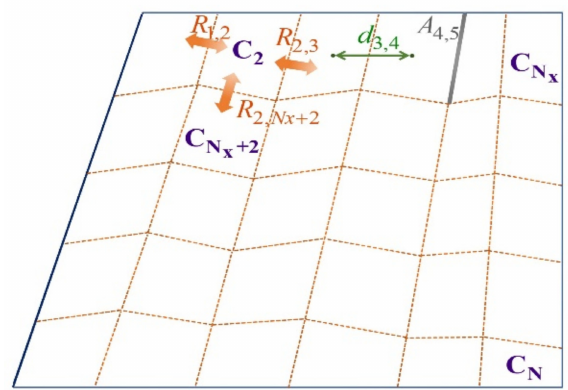
Figure 3. Visualization of the generalized variables. The red arrows symbolize conductive (heat) transport between cells with heat capacities C i and C j through the resistances R ij